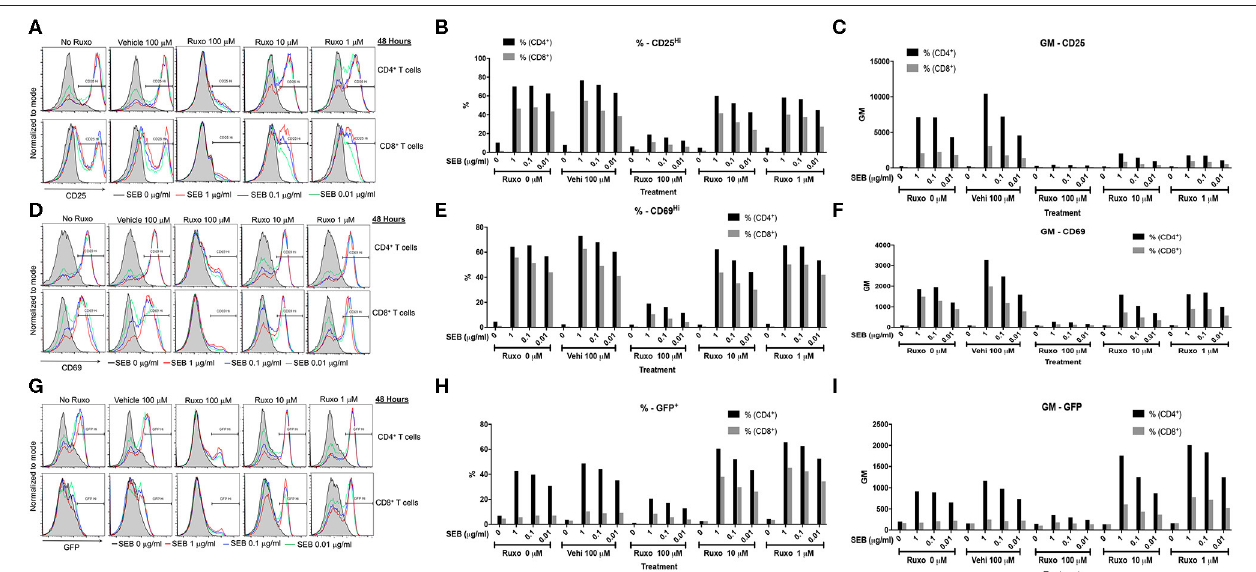
FIGURE 7 | Ruxolitinib inhibits SAg-induced T cell activation in vitro . Splenocytes from HLA-DR3.Nur-77 GFP transgenic mice were cultured with medium alone or with indicated concentrations of SEB in the presence of ruxolitinib or vehicle for 48h. After the incubation period, cells were washed, stained with indicated antibodies for flow cytometry. Expression of activation markers on CD4 + and CD8 + -gated T cells was determined. Histogram plots, % of cells expressing the given marker and geometric mean of expression of indicated markers. CD25 (A–C) , CD69 (D–F), and GFP (G–I) . Representative histograms and corresponding bar charts from one set of experiments.